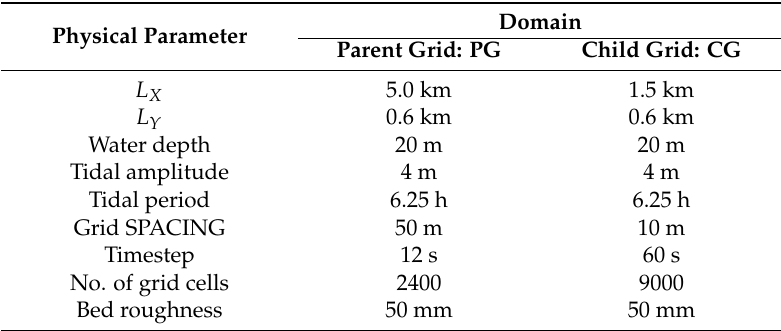
Table 1. Summary of idealised channel model